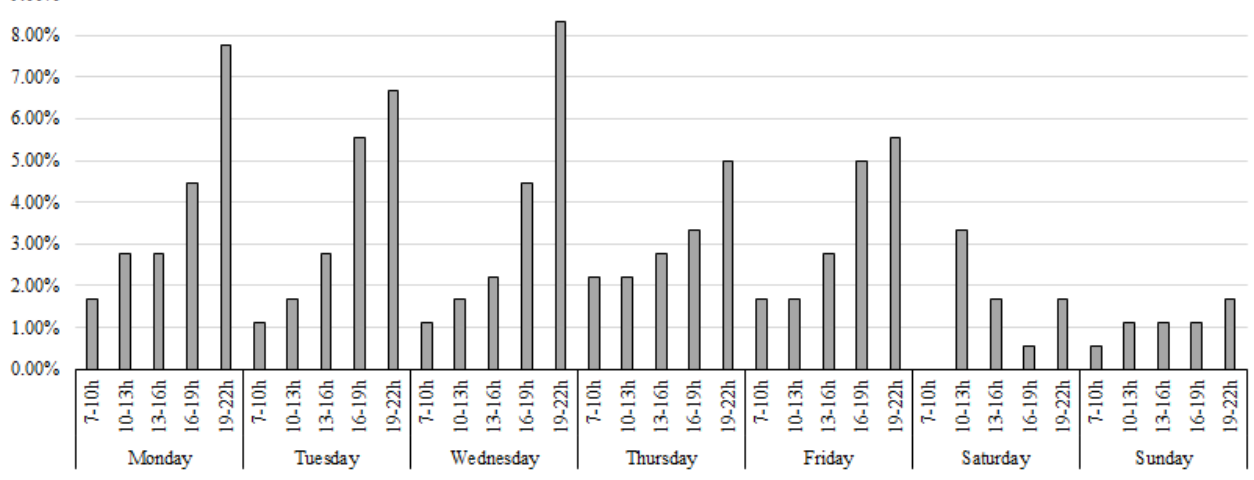
Figure 3. E-grocery delivery preferences per day of the